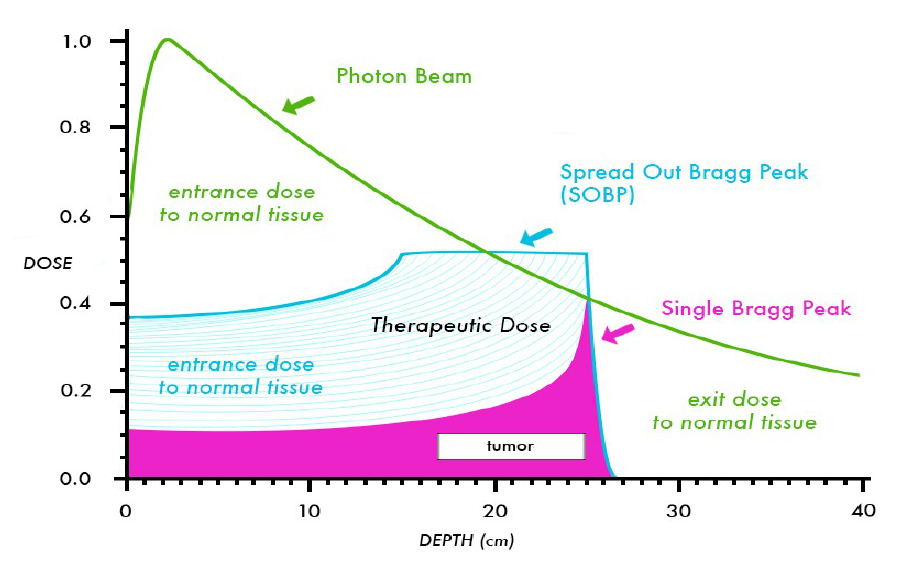
Figure 1. Comparison of depth dose curves for a 10 MV photon beam and a 10 MeV proton beam (shown with and without a SOBP). This figure shows the decreased entrance dose and absence of exit dose for the proton beam in comparison to the photon